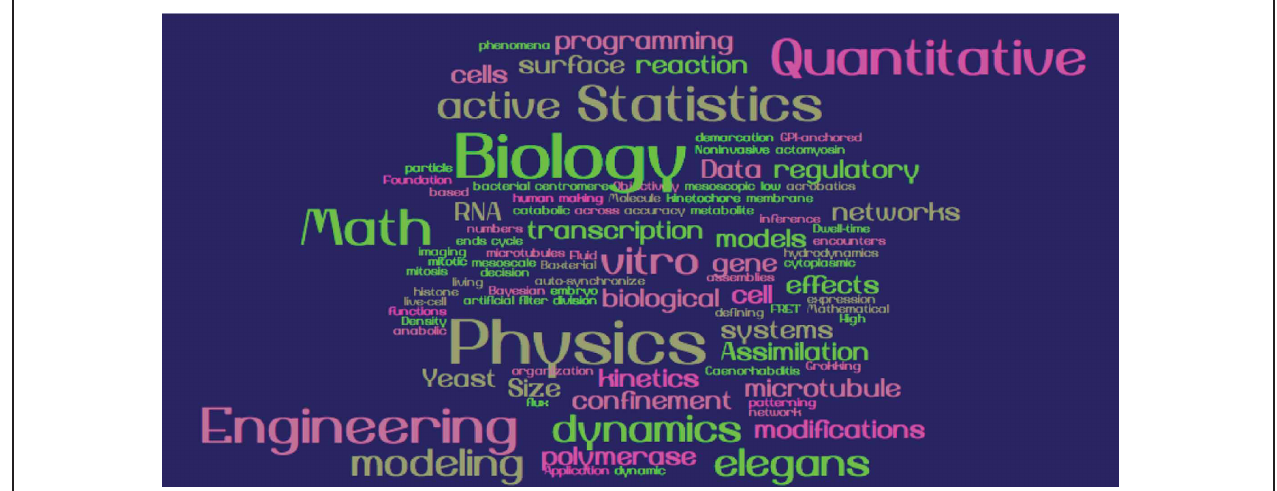
FIGURE 1 | Visual representation of keywords provided by meeting participants to describe their research area of interest. The weighted list was generated using Word Cloud.